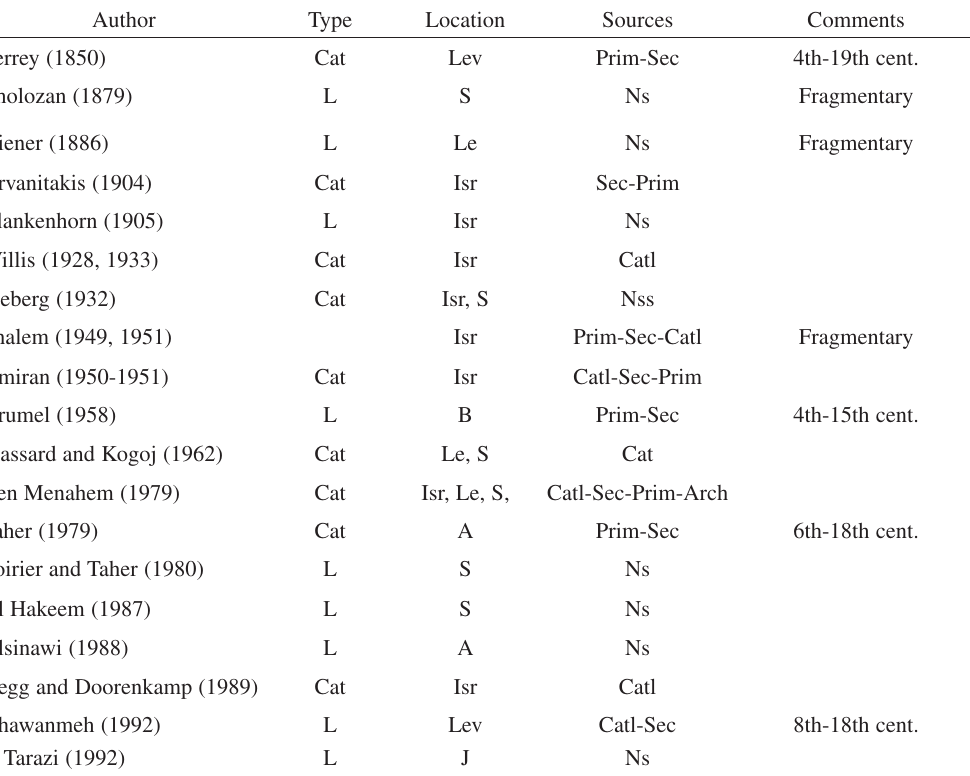
Table I. Catalogues and lists of historical earthquakes in the Holy